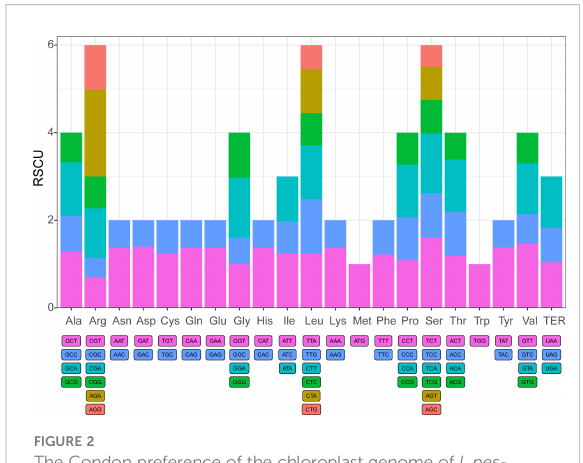
FIGURE 2 The Condon preference of the chloroplast genome of I. pes- caprae . Codon content of 20 amine acid and stop codons in all protein-coding genes of the chloroplast genome of I. pes-caprae